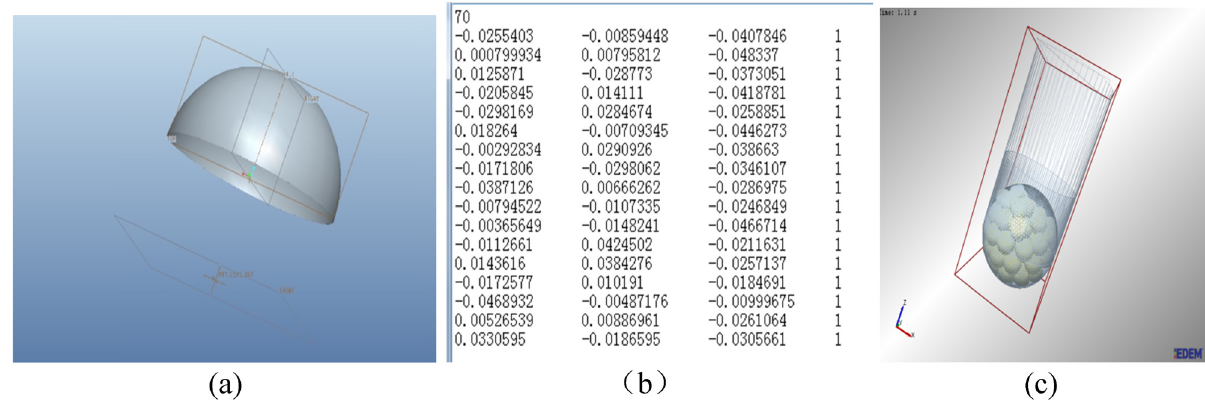
Figure 3: Simulation of the ball model. ( a ) The built model. ( b ) TXT document, and ( c ) The simulated ball model.